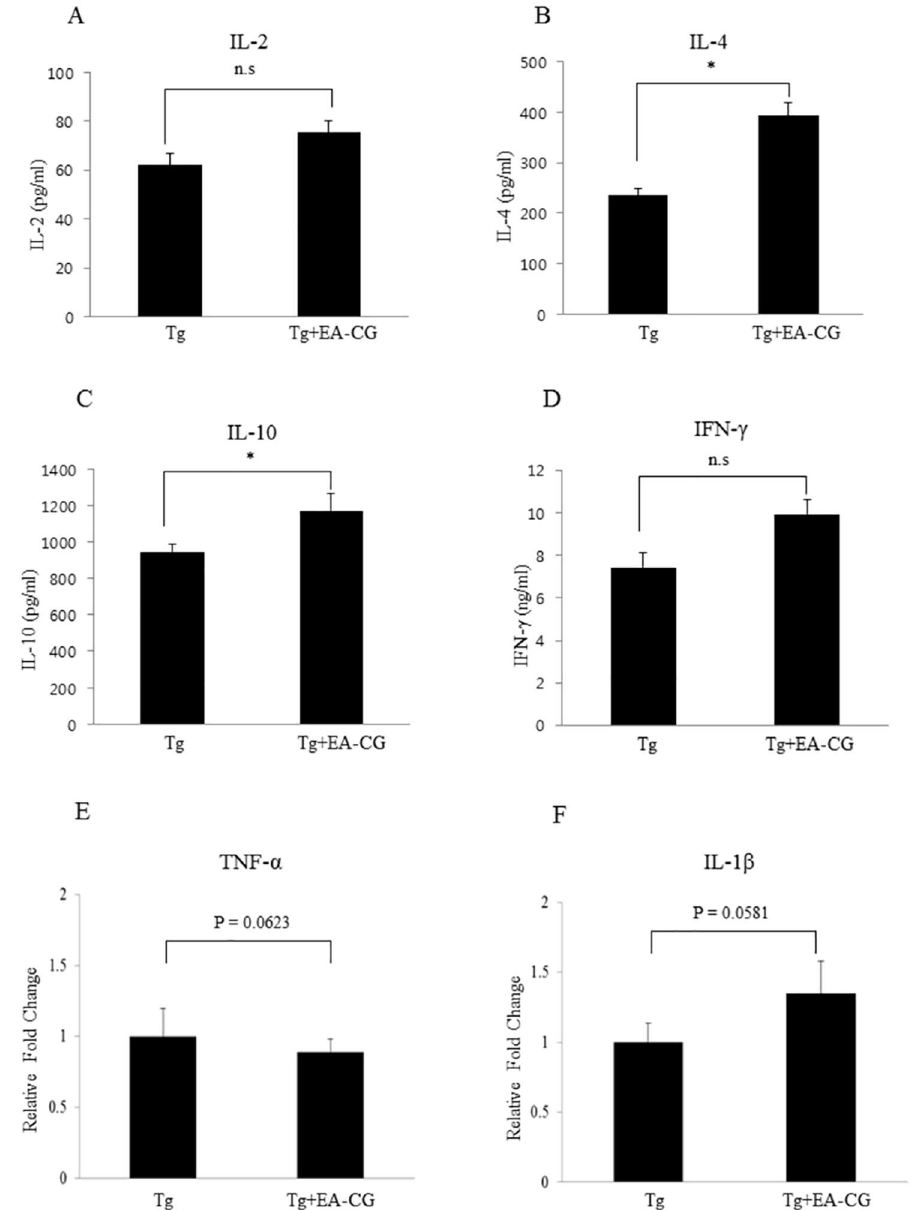
Fig 4. Comparison cytokine profile between Th1 and Th2 CG in the Tg brains by the CG extracts. The T cell-mediated inflammatory response, includingTh1 (IL-2 and IFN- γ ) (A, D) and Th2 (IL-4 and IL-10) (B, C) cytokines, was measuredby a cytokine ELISA using the EA-CG-treated Tg (Mo/Hu APPswe PS1dE9) mice comparedto the control (PBS) treated Tg mice. After the mice sera were isolatedby centrifugation, the levels of the pro-inflammatory cytokines (Th1: IL-2 and IFN- γ ) and anti-inflammatory cytokines (Th2: IL-4 and IL-10) were quantitatedand analyzedthe difference sera betweenin the EA-CG-treated and vehicle (PBS)-treated control Tg (Mo/Hu APPswe PS1dE9) mice. For quantifying pro-inflammation difference betweencontrol Tg and Tg+EA-CG in gene expressionprofile, gene of interest (TNF- α (E) and IL-1 β (F)) was presentedas relativefold change after normalized with housekeeping gene (GAPDH). The values were presented as the means ± S.E.M (n = 10 mice per each group). * p < 0.05. Tg vs. Tg+EA-CG; n.s. mean not significant.